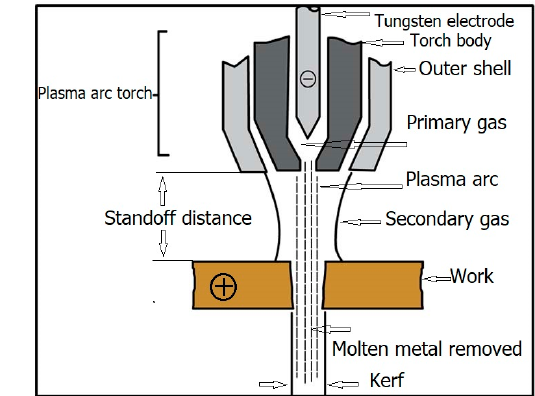
Figure 1. Schematic diagram of PAC.